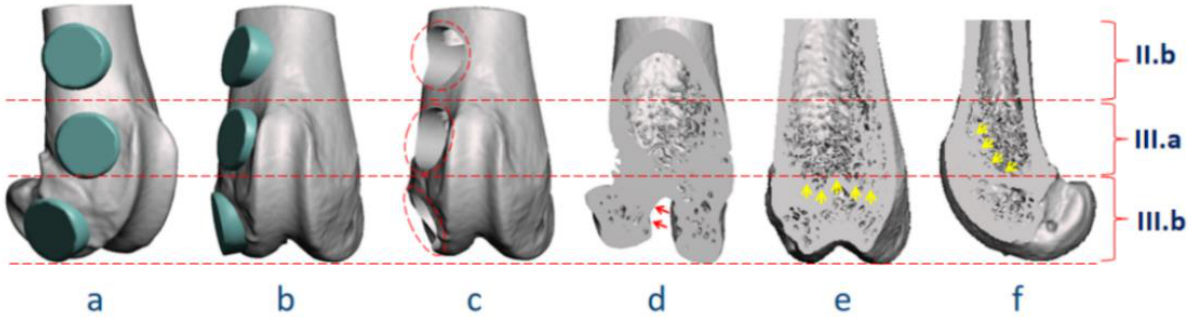
Figure 8. Virtual surgery and anatomical demonstration of potential surgical pitfalls in the distal femur. ( a – c ) Virtual surgery simulating the preparation of bone tunnels in anatomical Region II.b, III.a, and III.b; ( d – f ) three-dimensional reconstruction of the distal femur, showing the risk of growth plate (indicated by yellow arrows) injury in Region III, and condyle and ligament (indicated by red arrows) injury in Region III.b. Note: ( a ) Oblique-lateral view for surgical design; ( b ) ventral-dorsal view for surgical design; ( c ) ventral-dorsal view after virtual surgery; ( d ) oblique-frontal plane; ( e ) frontal plane; and ( f ) sagittal plane.